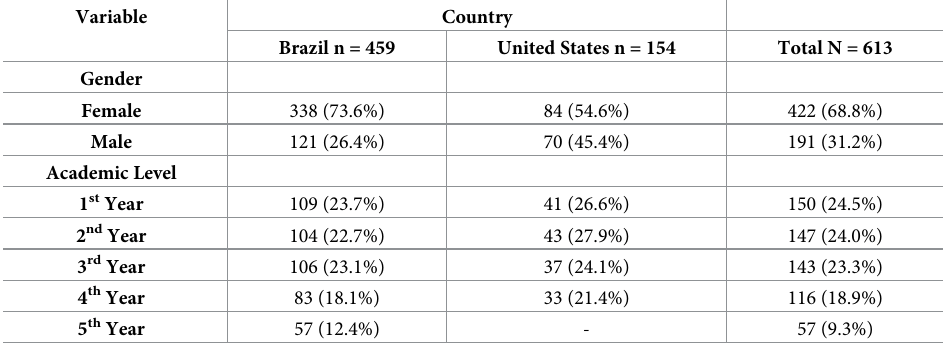
Table 1. Demographic characteristics of the study